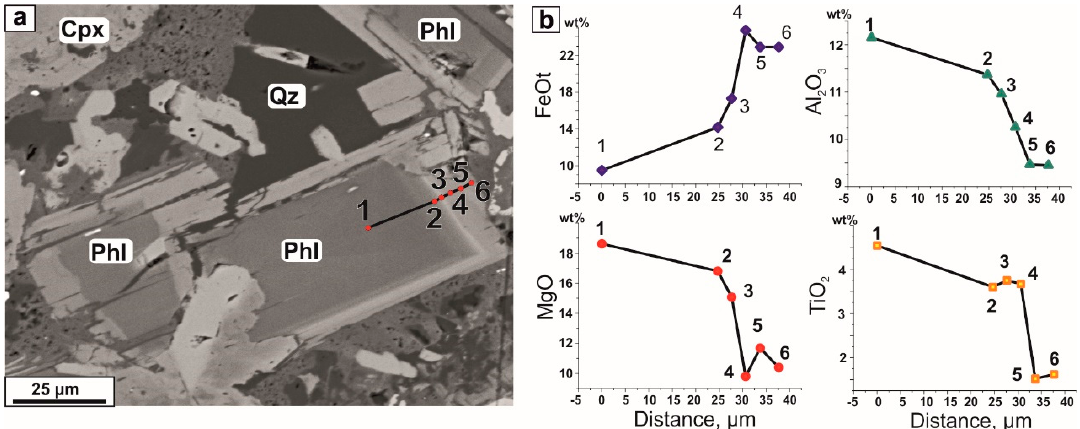
Figure 5. Mineral composition of phlogopite crystal according to electron microprobe analyses (EPMA) analyses (wt%): ( a ) BSE-photo, ( b ) variations of components along the profile line.